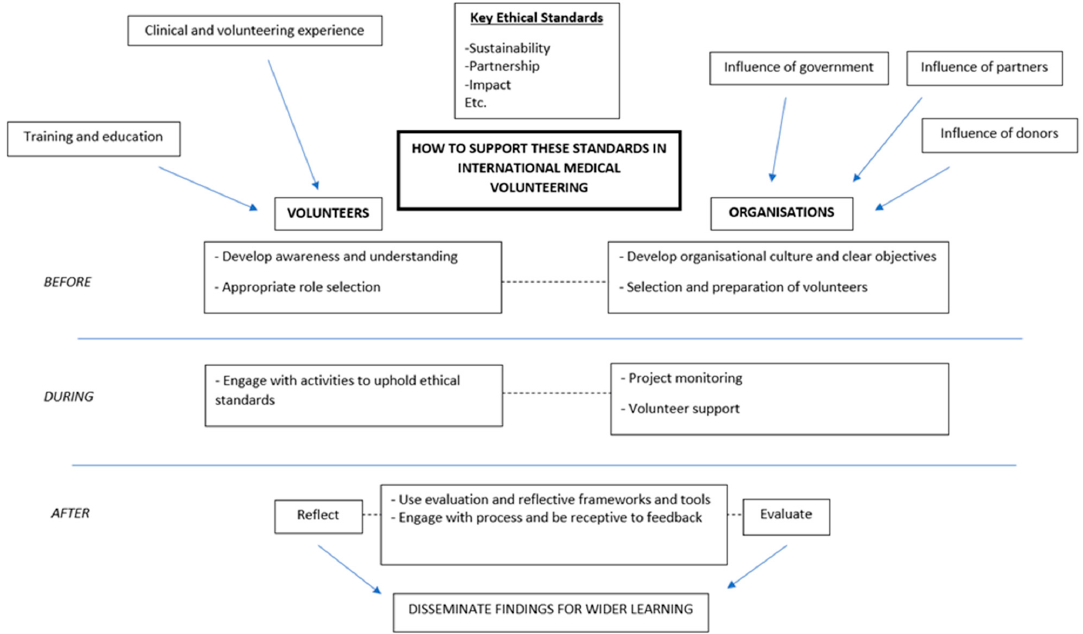
Figure 1. Processes influencing the maintenance of ethical standards in volunteering in low- and middle-income countries (LMICs).